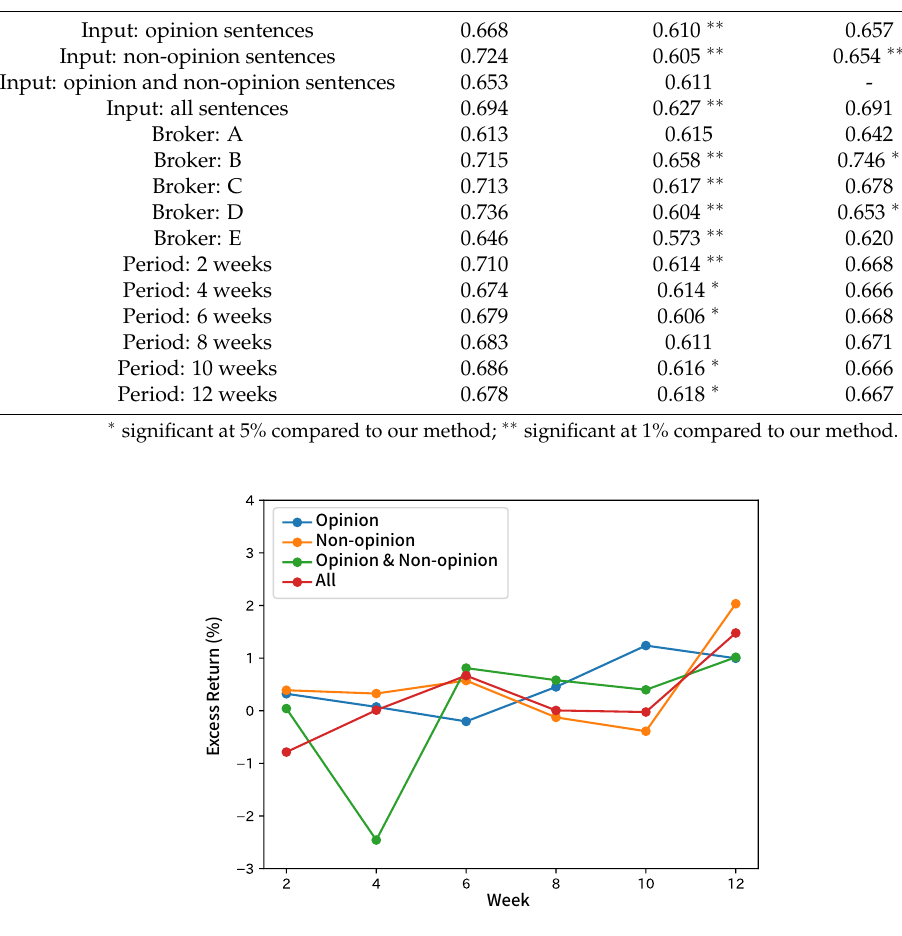
Figure 4. Excess returns of Broker A in forecasting analyst net income